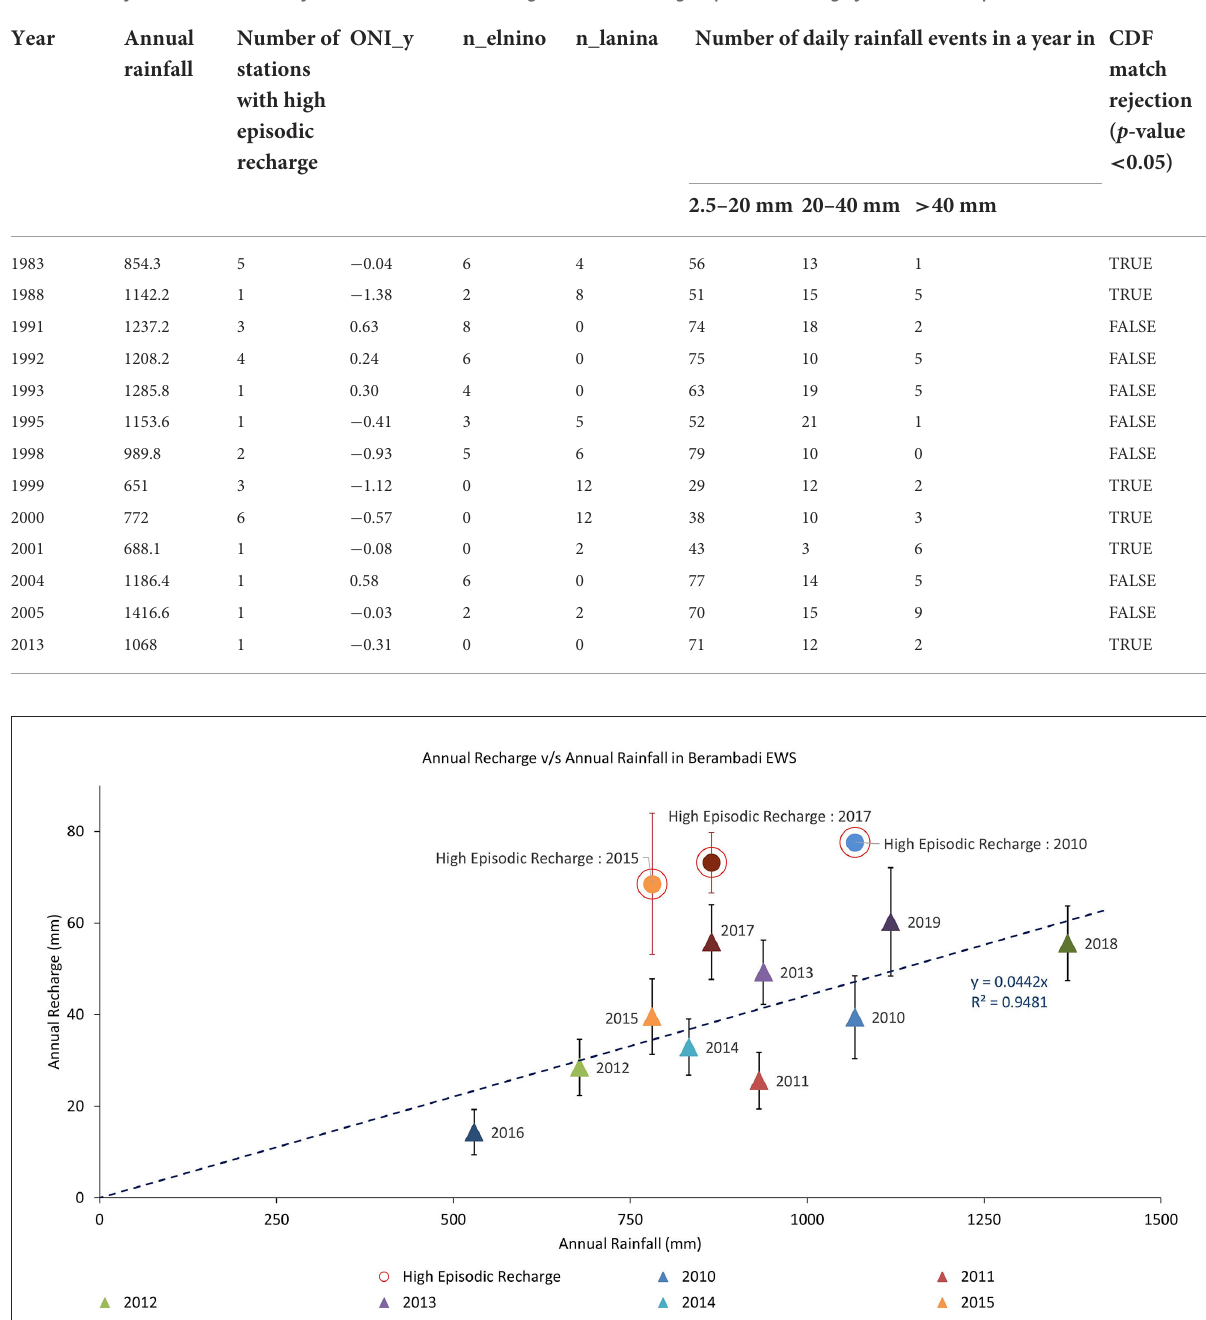
FIGURE7 Annual recharge vs. annual rainfall variation in Berambadi EWS.